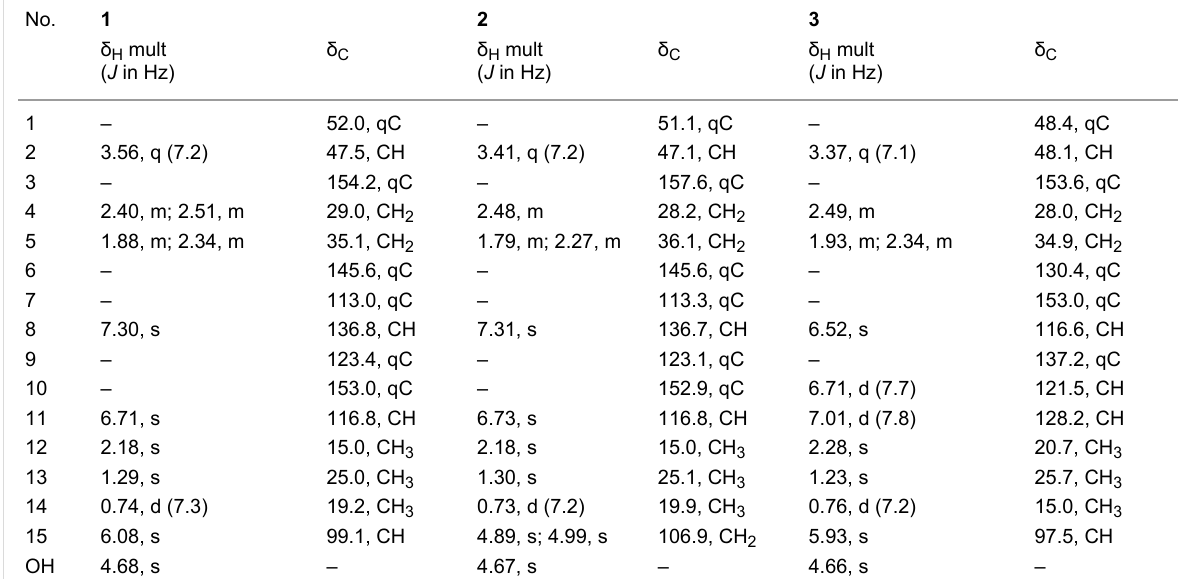
Table 1: 1 H and 13 C NMR data of 1 – 3 a recorded in CDCl 3 . No.